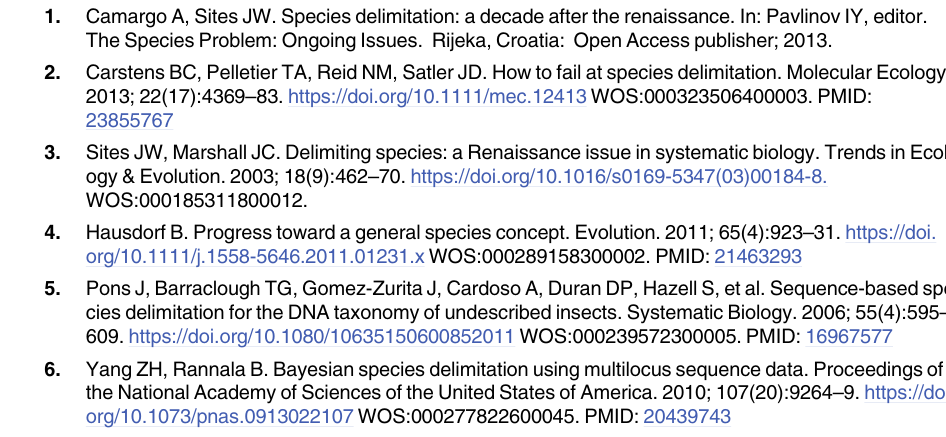
S2 Table. GenBank accession numbers for S1 Fig. GenBank accession numbers of sequence used in the analysis of Fig 1S for gen cytochrome c oxidase subunit I (COI).